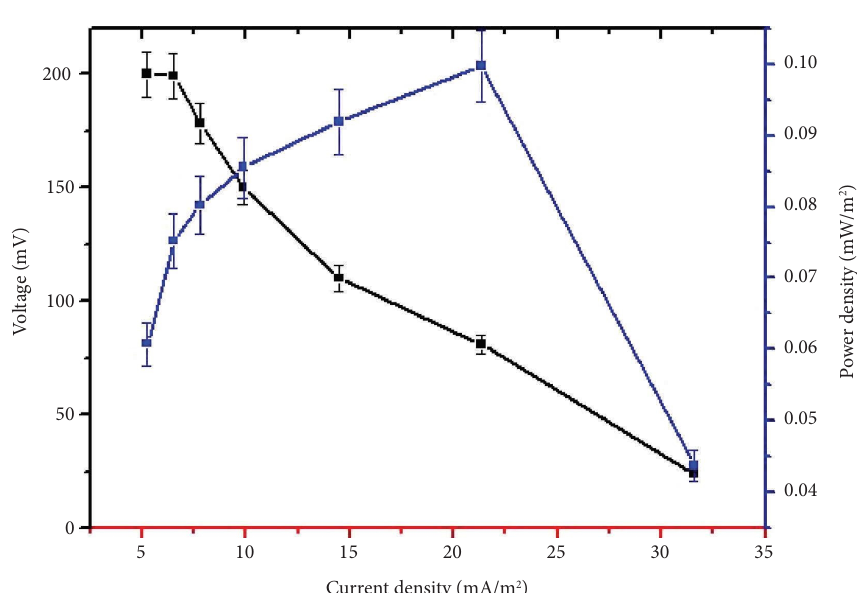
Figure 1: Voltage trend during the MFC operation for